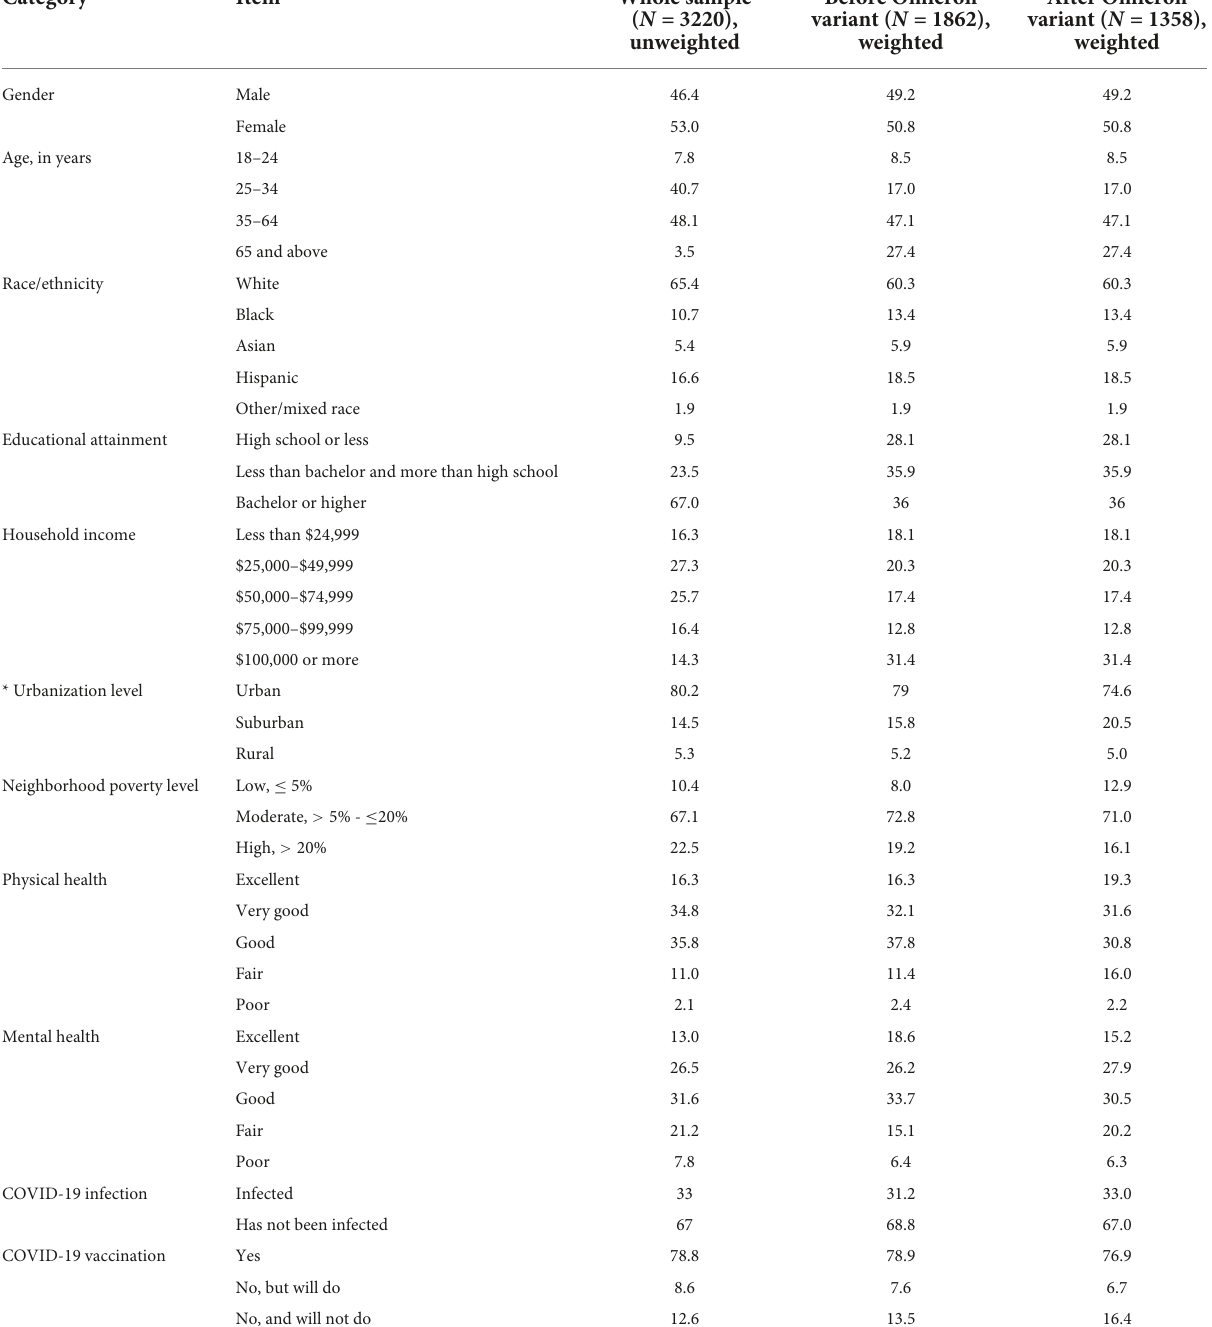
TABLE 1 Characteristics of